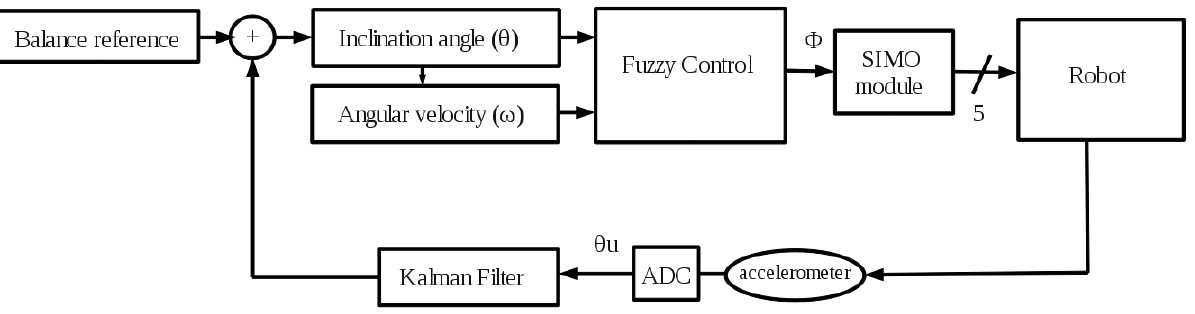
Figure 4. Balance control process in the frontal plane of the